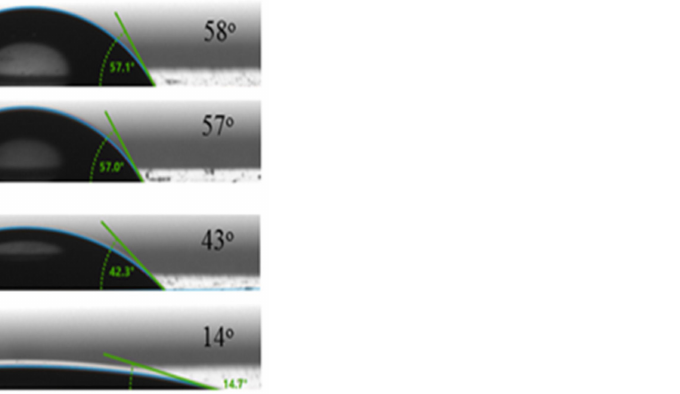
Figure 6. Water contact angles of hard-templated Nb 2 O 5 films obtained by liquid phase mixing of Nb sol and silica colloids in different volume ratios indicated in the figure.